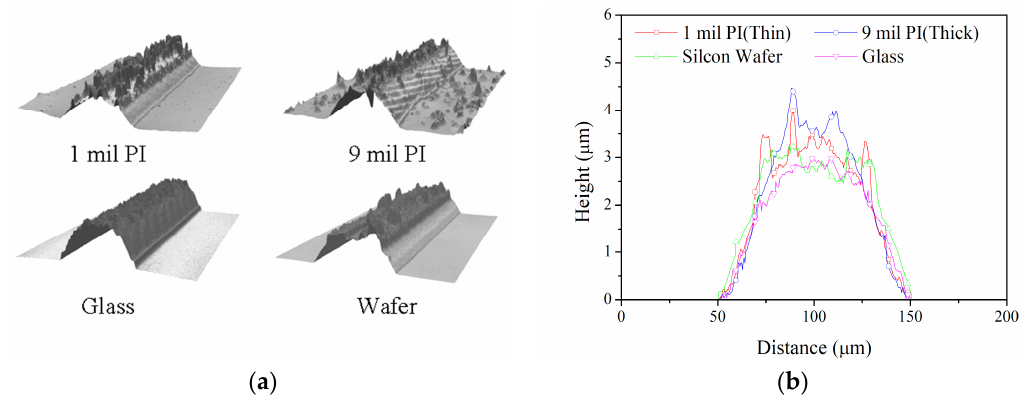
Figure 3. Surface morphology of inkjet-printed Ag thin films sintered on various substrates. ( a ) The typical surface image and ( b ) profiles of the substrates. PI: Polyimide.